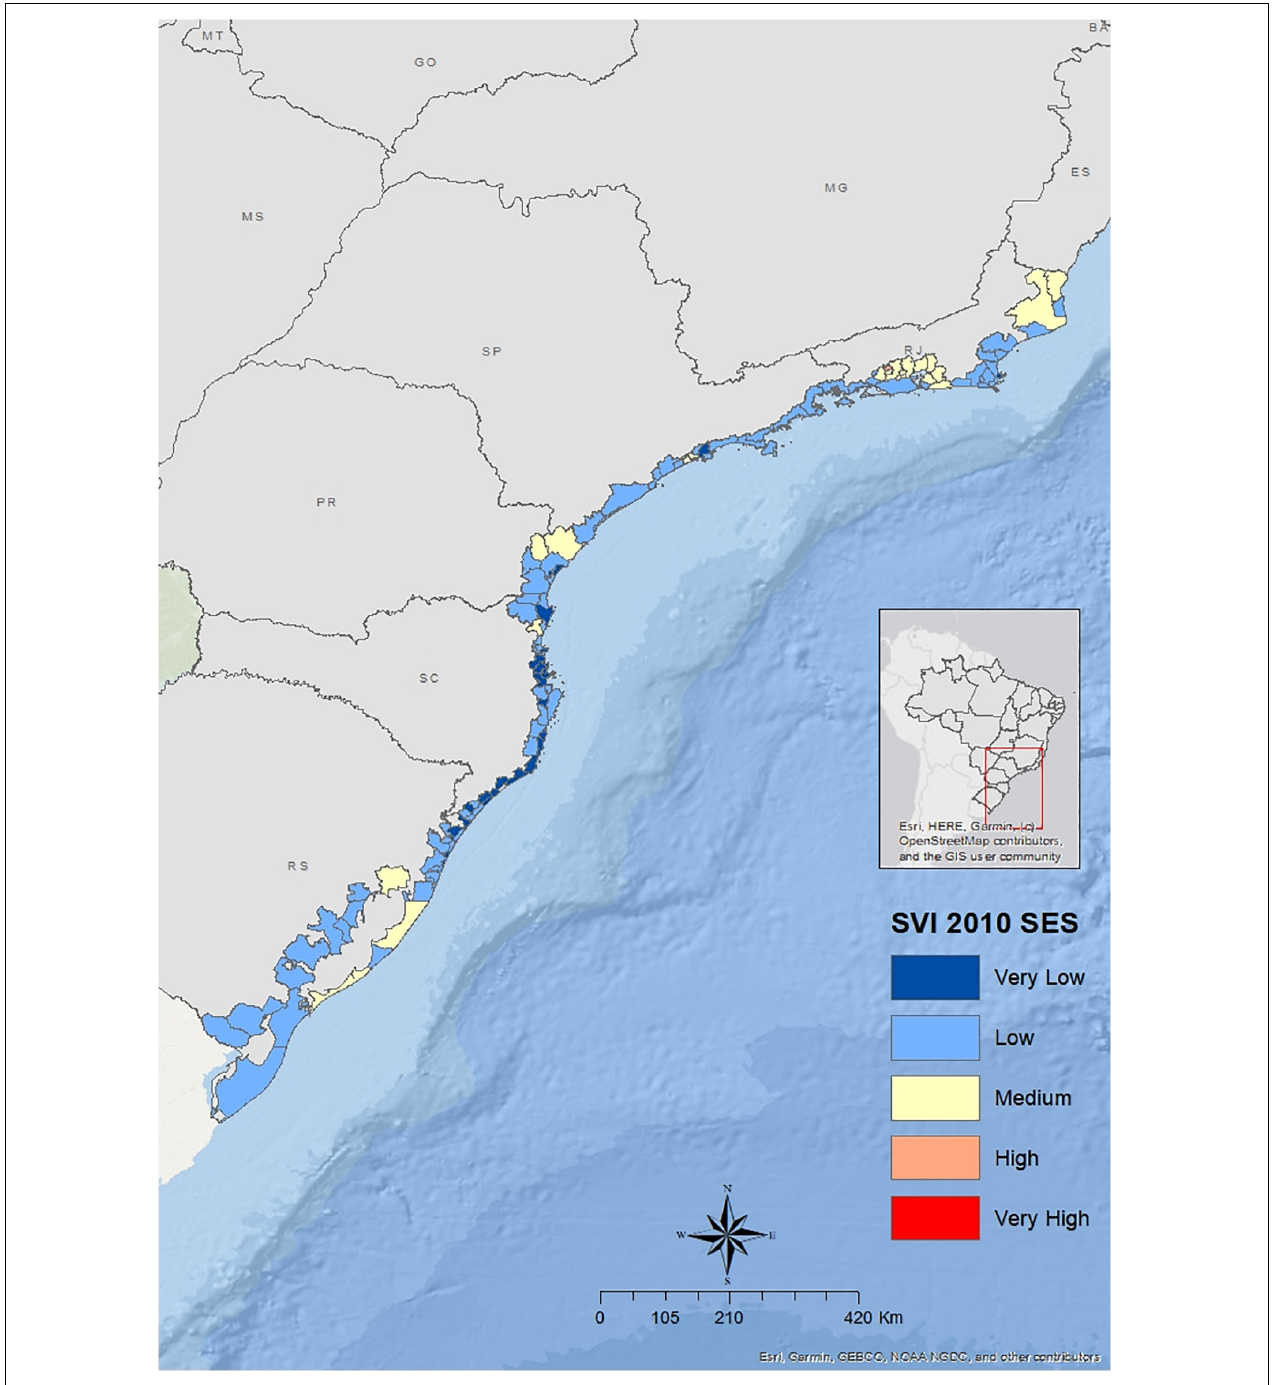
FIGURE 10 | SVI for the South coast municipalities. Elaborated by the authors with data from IPEA